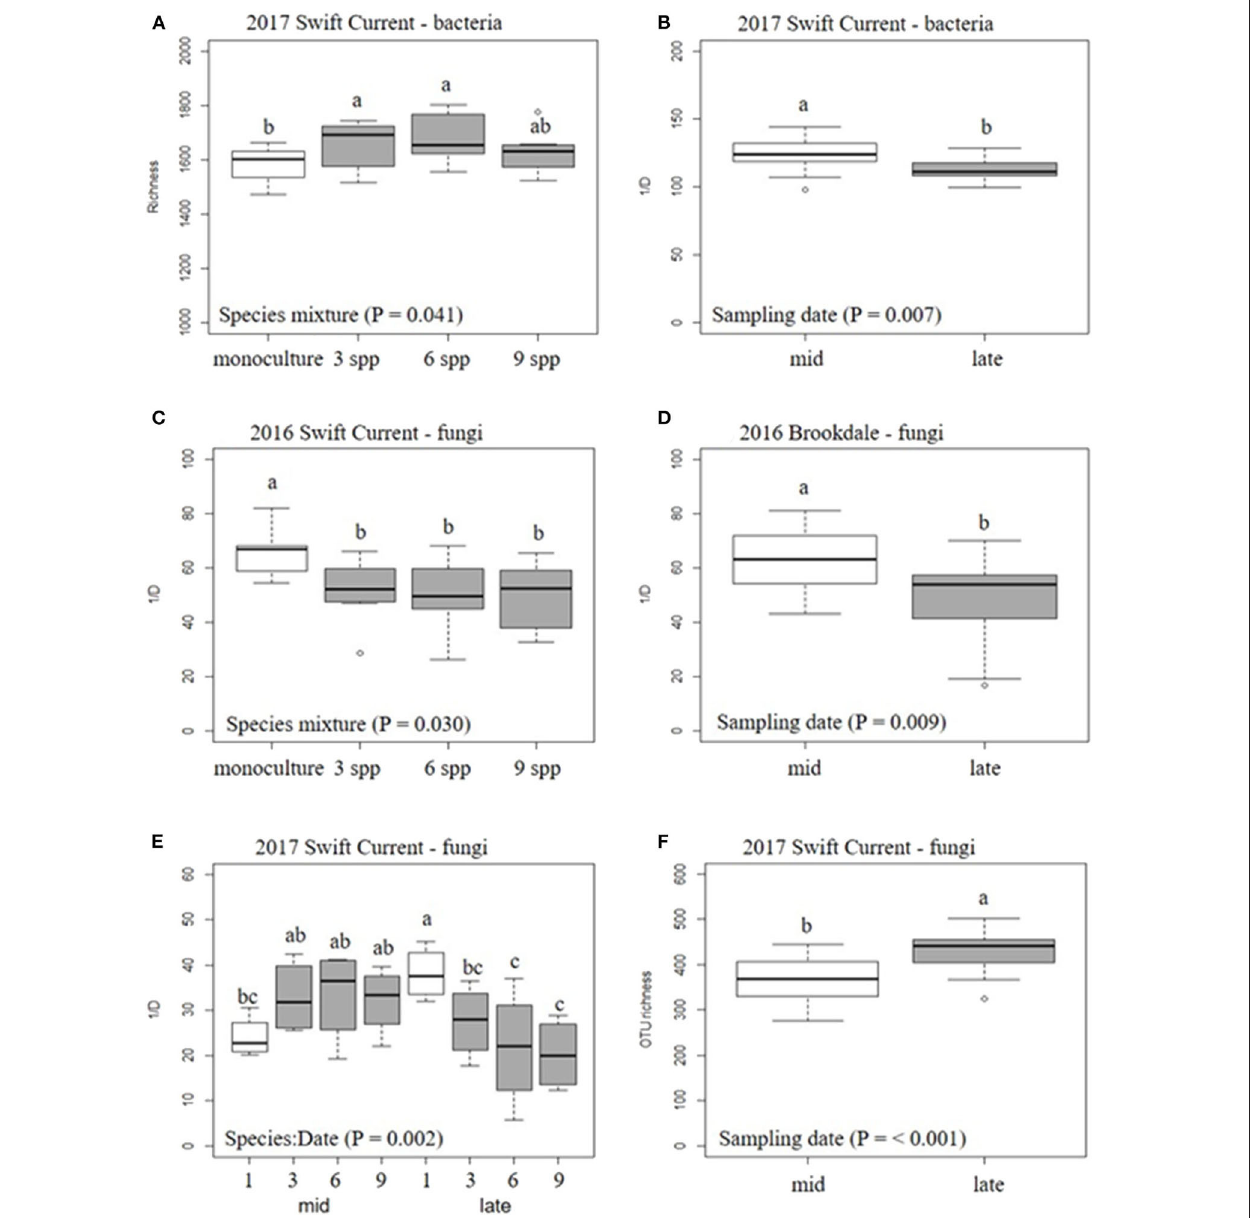
FIGURE 2 | Boxplots of the effect of cropping mixtures (monoculture, three, six, and nine spp.) and date of sampling (mid or late growing season) on bacterial (A,B) and fungal (C–F) α -diversity at the Swift Current and Brookdale research sites. Bars with different letters are significantly different ( p < 0.05).